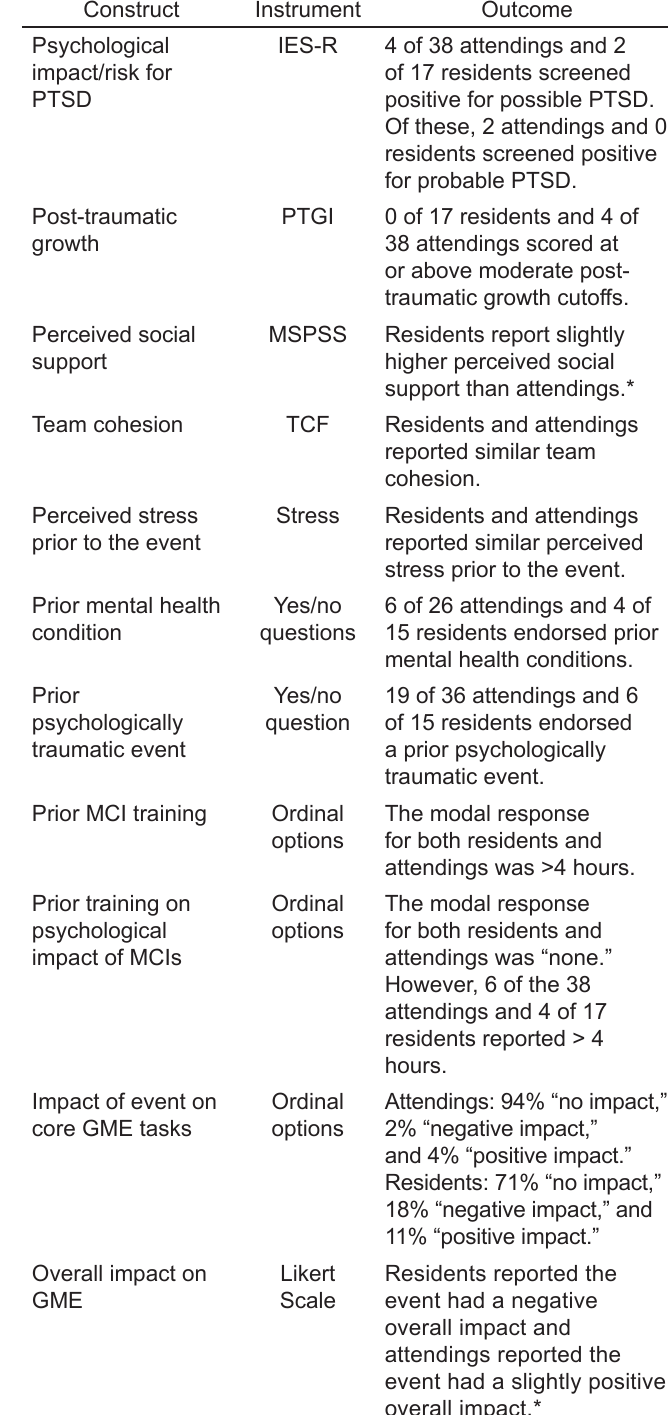
Table 3. Summary outcomes of measured